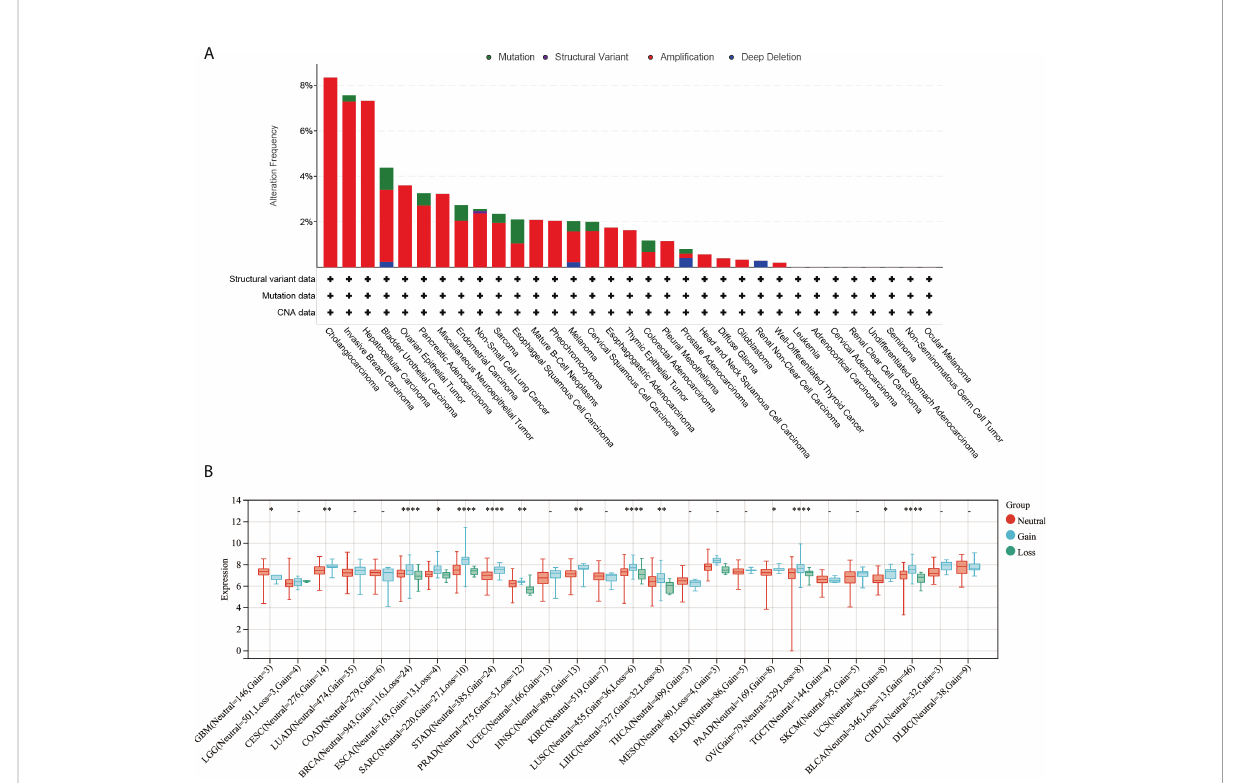
FIGURE 2 Genetic alteration of ARPC5 in pan-cancer. (A) Mutation type and mutation frequency of ARPC5 obtained from the cBioPortal website. (B) The expression levels of ARPC5 in various CNV status of pan-cancer, CNV, copy number variations; *p < 0 . 0 5 ; * *p < 0.01; ****p <